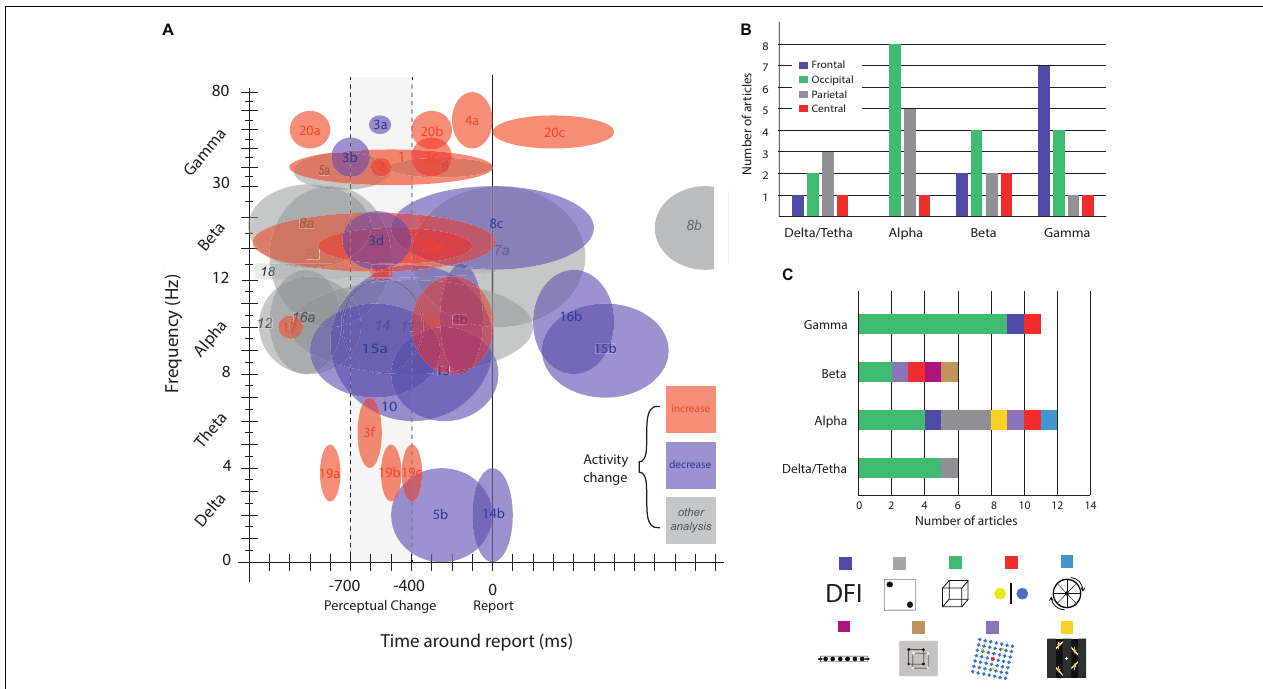
FIGURE 3 | Brain activity modulation by time, frequency, and area. (A) Brain oscillatory activity modulation related to bi-stable perception. Numbers indicate references and letters brain areas or other commentaries. (B) Articles published on bi-stable perception grouped by oscillatory frequency band and colored by brain area. (C) Number of published articles grouped by frequency band, colored by bi-stable stimulus. References: (1) Basar-Eroglu et al. (1996); (2) Doesburg et al. (2009); (3) Ehm et al. (2011), [a] frontal, [b] occipital, [c] central, [d] parietal, frontal, central, [e] occipital, parietal, [f] occipital; (4) Lange et al. (2013) [a] gamma power correlates with subjective perception, [b] alpha power inversely correlate with subjective perception; (5) Mathes et al. (2006), [a] enhanced for hold condition, [b] a decrease in delta wave around this time window is observed; (6) Strüber and Herrmann (2002); (7) Kloosterman et al. (2015), [a] decrease for illusory disappearance and increase for reappearance, [b] decrease before reappearance; (8) Piantoni et al. (2010), [a] higher for veridical percept, [b] decrease for BR and Moving dots illusion around report; (9) Zaretskaya and Bartels (2015), beta decreases more for local percept. (10) Basar-Eroglu et al. (2016), alpha power was even more decreased in patients with schizophrenia. (11) Flevaris et al. (2013), there were more decrease for object percept compared with fragment percept; (12) Händel and Jensen (2014), there is a significant alpha lateralization preceding the estimated illusory disappearance of the stimuli, the level of lateralization predicts the duration of the following illusion; (13) Isoglu-Alkaç and Strüber (2006), alpha band activity was lower in the interval between 500 and 1000 ms before report than 0–500 ms before; (14) Mathes et al. (2010), [a] alpha power is higher on parietal and occipital electrodes for standard report, compared with delayed one, [b] a decrease in delta wave is observed around perceptual change (in standard and delayed conditions); (15) Piantoni et al. (2017), [a] alpha power start decreasing 900 ms before report, reaching it minimum at 250 ms, [b] after 250 ms alpha power start increasing until 850 ms after report (reaching starting levels). (16) Piantoni et al. (2010), [a] veridical percept show higher alpha activity, [b] after report of both veridical and illusory percept alpha power decreases; (17) Strüber and Herrmann (2002), the decrease in activity was not observed for exogenous induced changes; (18) VanRullen et al. (2006); (19) Ozaki et al. (2012), [a] frontocentral, [b] parietal, [c] central parietal; (20) Devia et al. (2020), [a] frontal, parietal, occipital, [b] parietal-occipital, [c] parietal-occipital, [d] frontal, [e] parietal-occipital, [f] occipital; (21) Yokota et al.